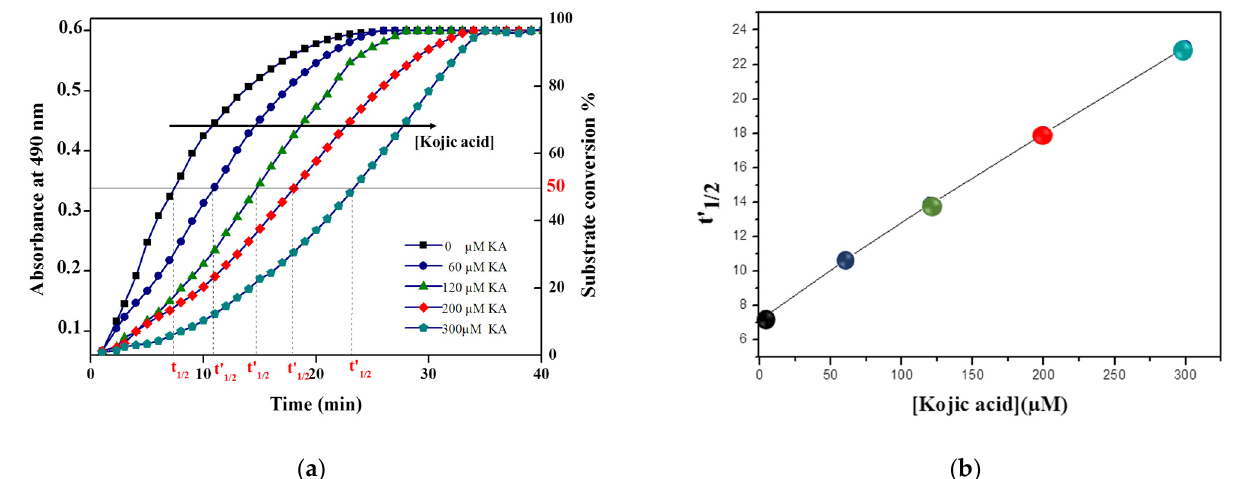
Figure 4. ( a ) The half-time reaction values ( t ’ 1/2 , t 1/2 ) by the progress curves of tyrosinase enzyme in the presence of 2 mM L-tyrosine and the presence of different concentrations of kojic acid. ( b ) Curve of t ’ 1/2 versus kojic acid concentrations. Phosphate buffer pH 6.8. Data are mean ± SD, n = 3.